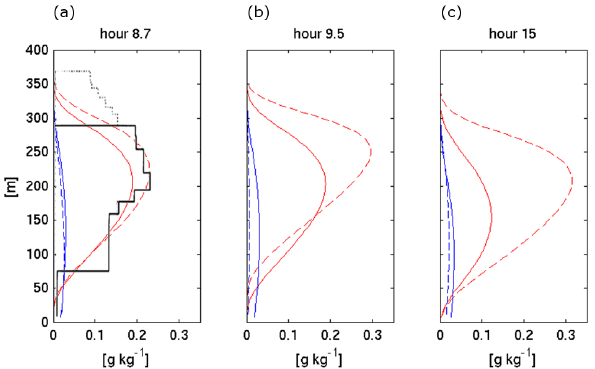
Figure 12. Profiles of cloud (red lines) and rain (multiplied by factor of 4 for clarity; blue lines) water mass mixing ratios, regionally av- eraged in the ship track (dashed lines) and background (solid lines) in run BaseTrack. Plots are shown for hours (a) 8.7, (b) 9.5, and (c) 15. Black overlay in (a) is the composited observational profile for q l from Taylor and Ackerman (1999).